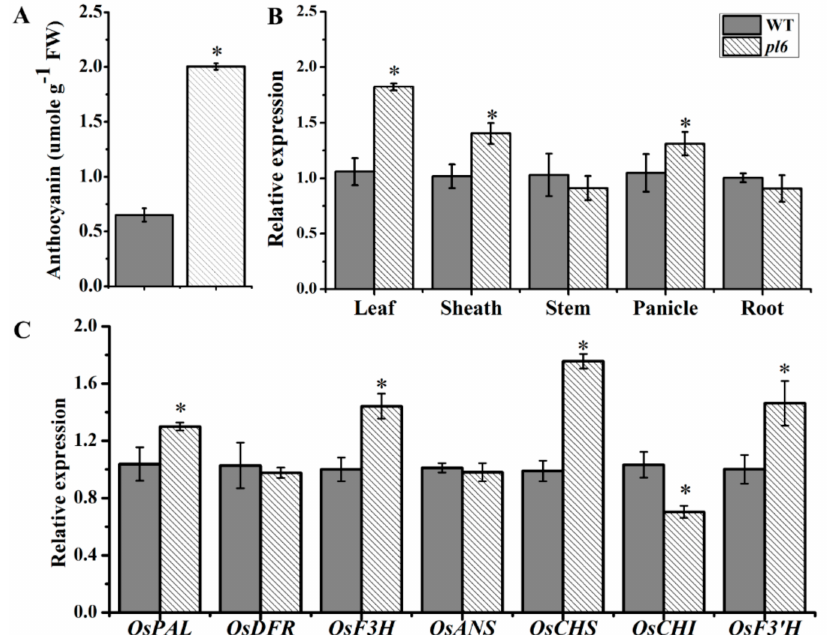
Figure 3. Estimation of anthocyanin contents, tissue-specific expression of OsPL6 gene and related gene expression at the tillering stage. ( A ) Anthocyanin contents in leaves of WT and pl6 ; ( B ) The expression pattern of OsPL6 gene in di ff erent organs; ( C ) The expression profile of anthocyanin biosynthesis pathway genes between WT and pl6 at grain filling stage. * p < 0.05 following Tukey’s test. All data represent the mean ± SD of three